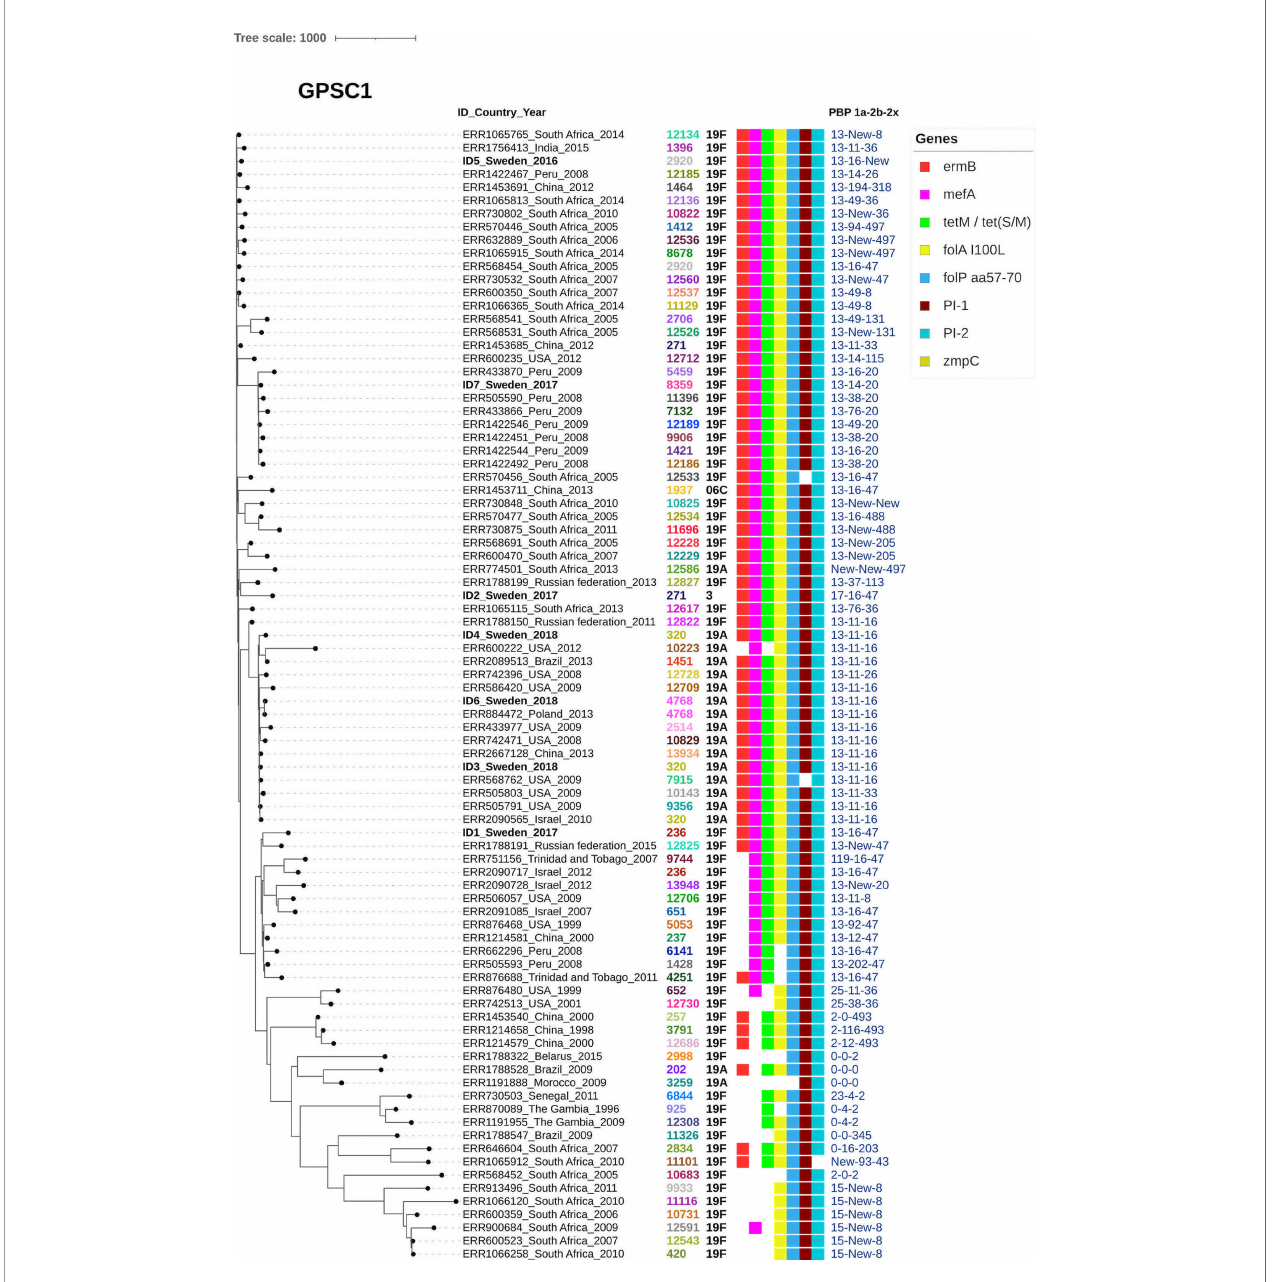
FIGURE 1 | Dual presence of both Pilus islet 1 and 2 is common within GPSC1. GPSC1 tree including 86 isolates showing ID number, country and year followed by serotype, MLST, gene presence and PBP-pro fi le (1a-2b-2x). As a reference isolate ID 1 was used. Almost all isolates (83/86) carry both Pilus islet 1 (PI-1) and Pilus islet 2 (PI-2). The three isolates that were negative for PI-1 or PI-2 however contained larger fragments of the corresponding pilus islets. All the Swedish isolates and many of the included (55/86) carry dual macrolide resistance mechanisms with both ermB and mefA . Regarding the PBP pro fi le PBP-1a allele 13 is common as well as the pro fi le 13-11-16. Zinc metalloproteinase C (ZmpC) was not found among either of the isolates